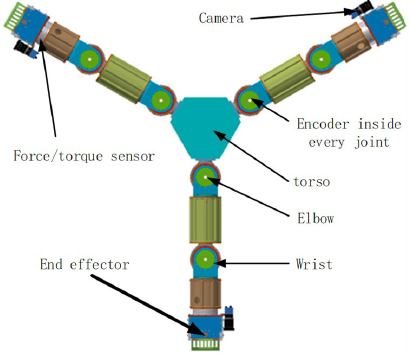
Figure 2. Overall structure of the robot.